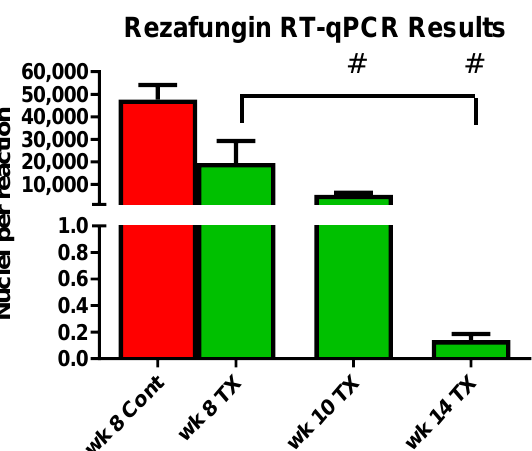
Figure 3. Treatment with rezafungin eliminates P. murina . Log 10 mean nuclei and asci counts after 2 to 8 weeks of rezafungin treatment. Color code: red = vehicle treated control bars; green =